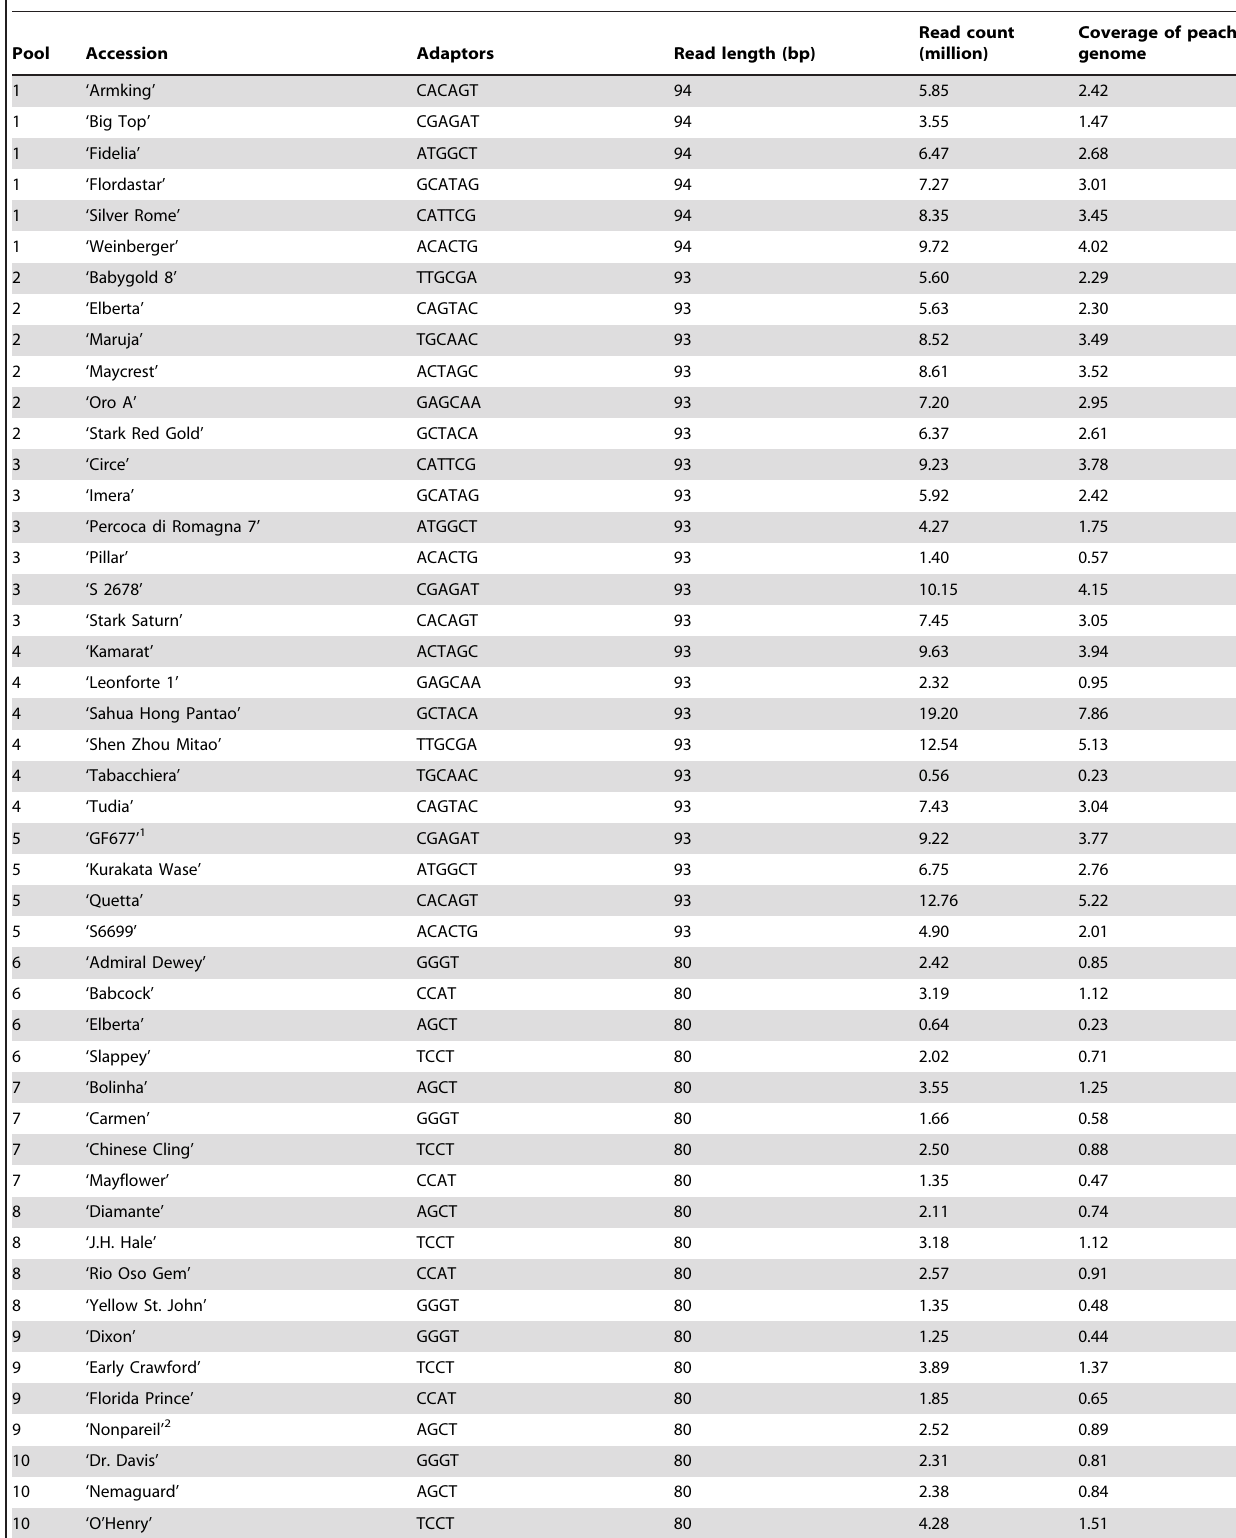
Table 1. Accessions of peach, almond and peach x almond hybrid sequenced at the Istituto di Genomica Applicata (IGA, Udine, Italy) (pools 1–5), the Center for Genome Research and Biocomputing (CGRB, Oregon State University, Corvallis, OR, USA) (pools